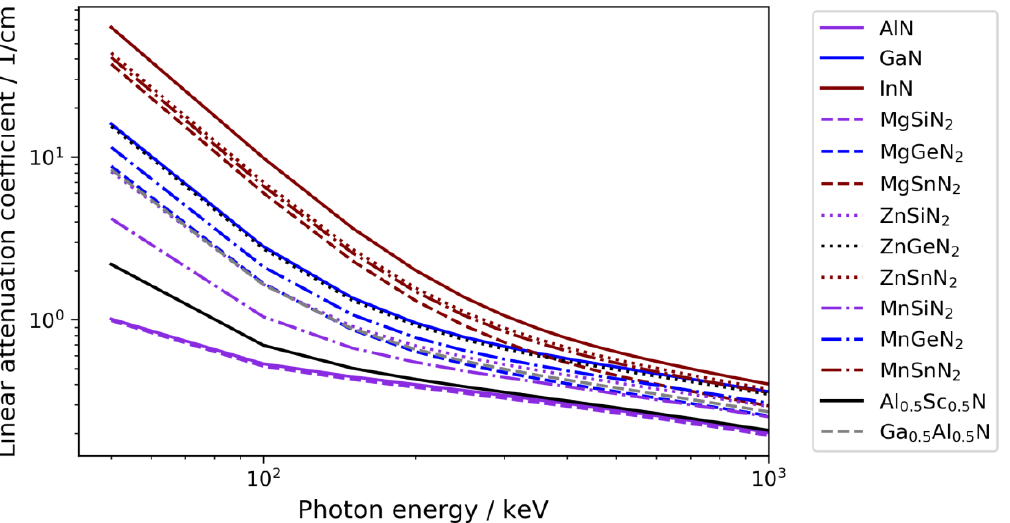
Figure 7. Linear attenuation coefficient of selected binary and ternary nitride materials. Data from the Photon Cross Sections Database XCOM of the National Institute of Standards and Technology (NIST) [21].